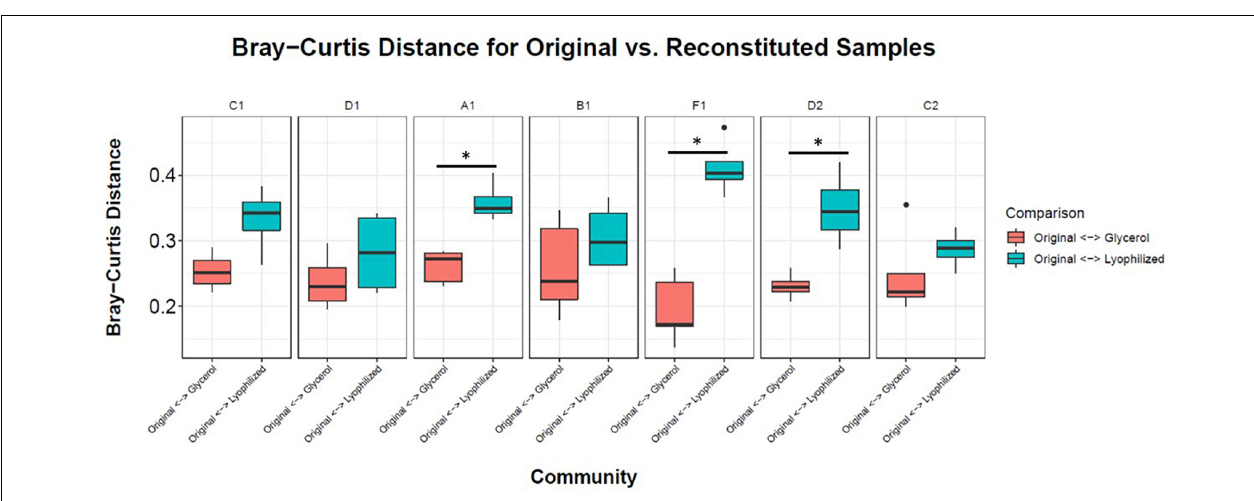
FIGURE 4 | Storage and reconstitution of consortia. Box and whisker plots showing the average Bray-Curtis distance of 4–5 replicates of reconstituted glycerol (red boxes) or lyophilized (blue boxes) stocks compared to the respective parent consortium on the plate. Asterisks indicate statistically significant differences ( < 0.03) between glycerol or lyophilized stocks by Wilcox rank sum